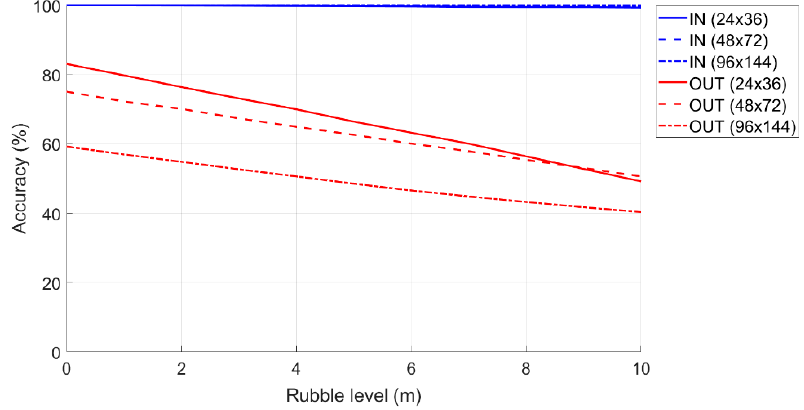
Figure 18. Accuracy in classification of the IN and OUT terminals as the rubble level increases.